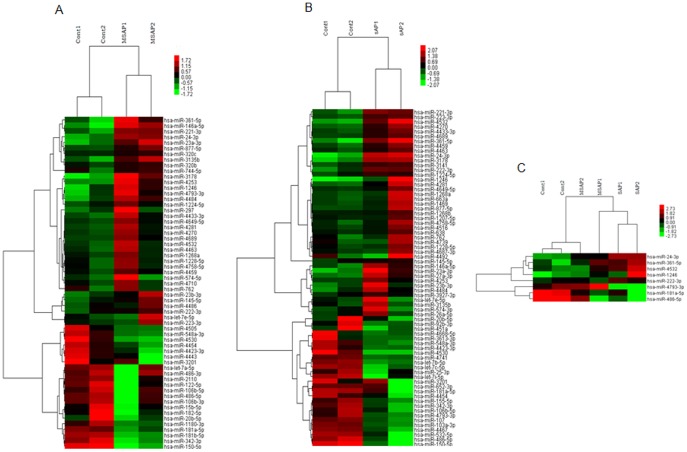
Microarray analysis of the serum miRNA expression profile of control MSAP and SAP patients.The expression profile of serum miRNAs was detected, using the LAN-based miRNA microarray. (A) There were 59 deregulated serum miRNAs (P<0.01) in MSAP patients and (B) 70 deregulated serum miRNAs (P<0.01) in SAP patients, compared with the healthy control group. (C) Among these deregulated miRNAs, eight were overlap miRNAs between the two AP groups. The top bar represents the signal levels of miRNA expression from −1.72 (green) to 2.73 (red). The individual identity of the significantly deregulated miRNAs is shown on the right border.